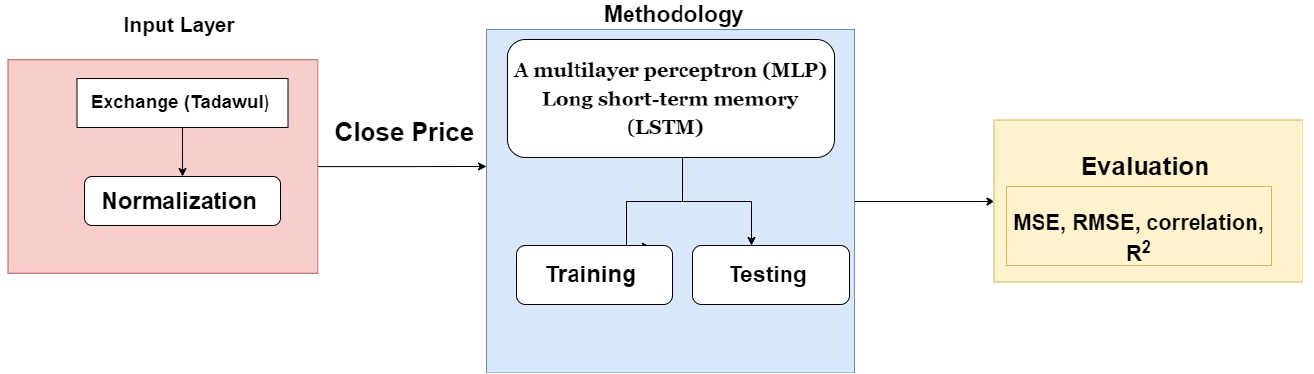
Figure 1. Framework for predicting Saudi Stock Exchange.